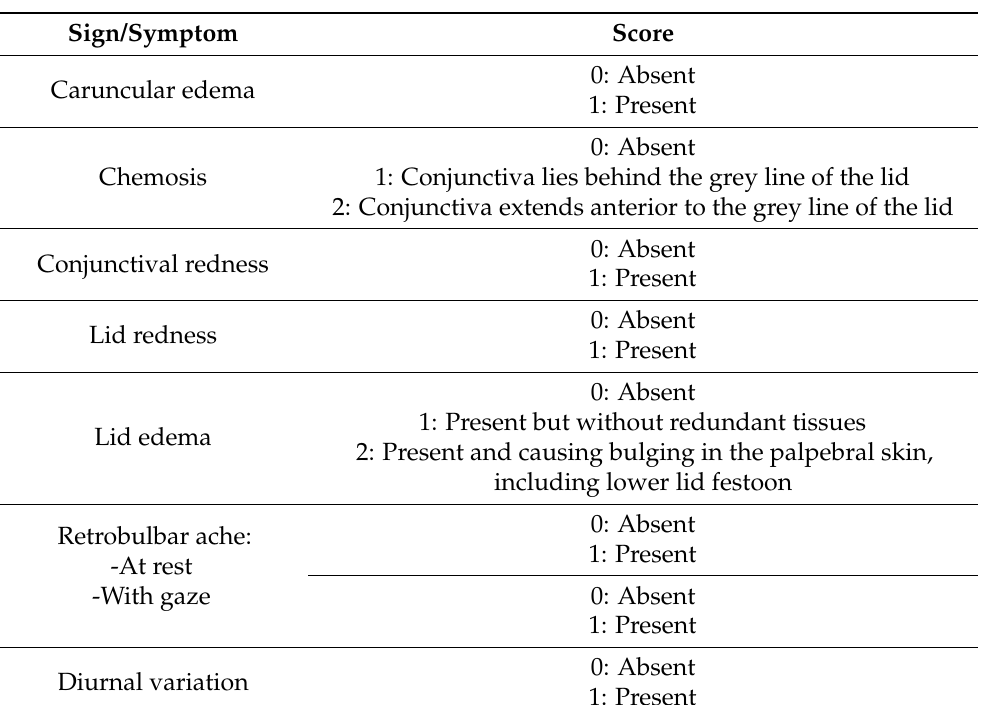
Table 4. VISA (Vision, Inflammation, Strabismus and Appearance) classification. Patients with moderate inflammatory index (less than 4 of 10) are managed conservatively. Patients with high scores (above 5 of 10) or with evidence of progression of the inflammatory process are offered a more aggressive therapy